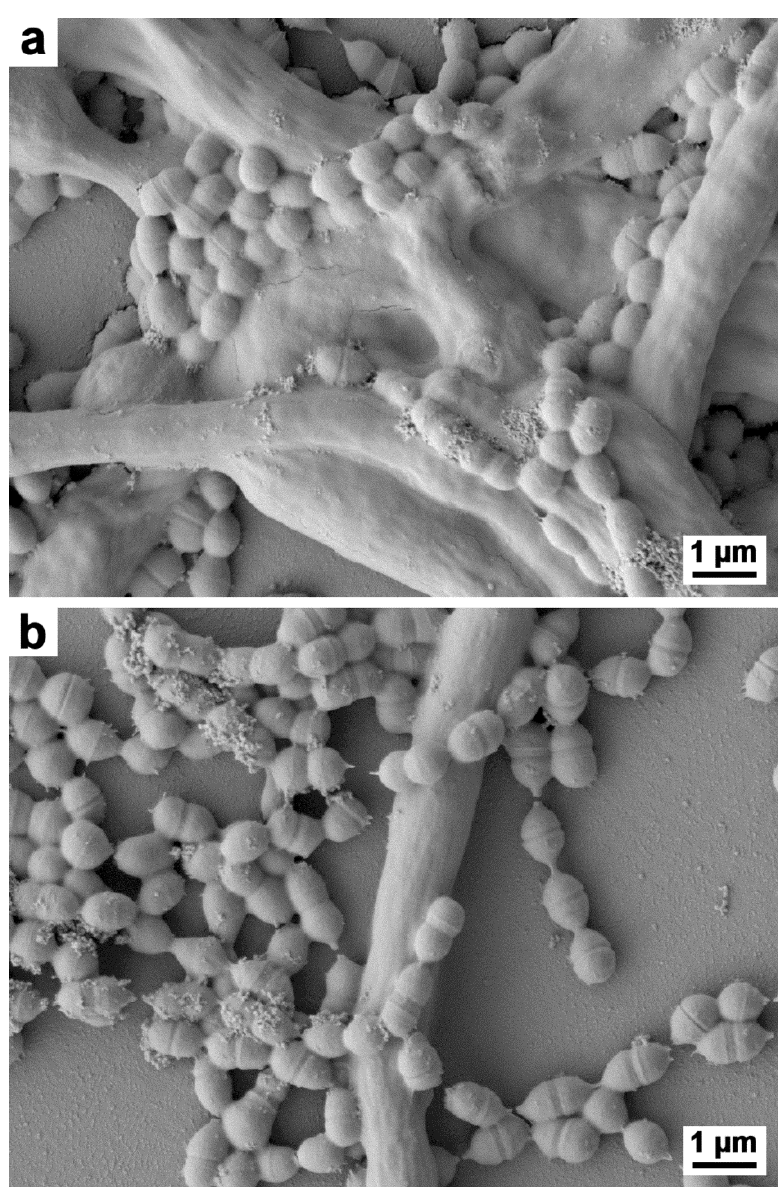
Figure 3. Co-culture of Candida albicans and Streptococcus salivarius . ( a ) Without Bucovia™. ( b ) With Bucovia™ 0.3% (x 10,000).